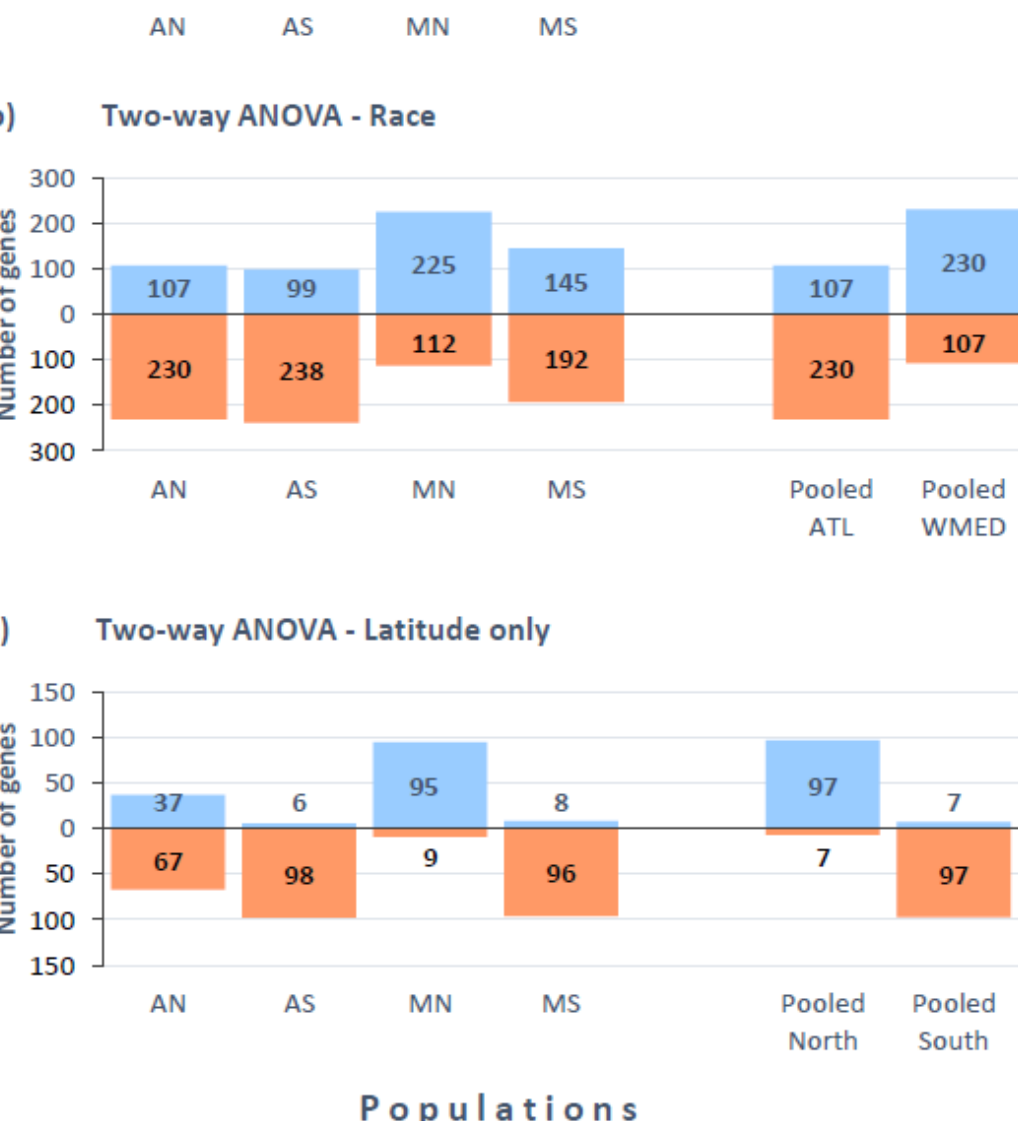
Figure 4. Bar charts showing the number of upregulated (blue) and downregulated (orange) genes according to the populations and type of statistical test. ( a ) One-way analysis of variance. ( b ) Two- way analysis of variance, Race factor. ( c ) Two-way analysis of variance, “Latitude only” gene set. Numbers for pooled samples of races and latitudes are also given when appropriate (( b ) and ( c )).